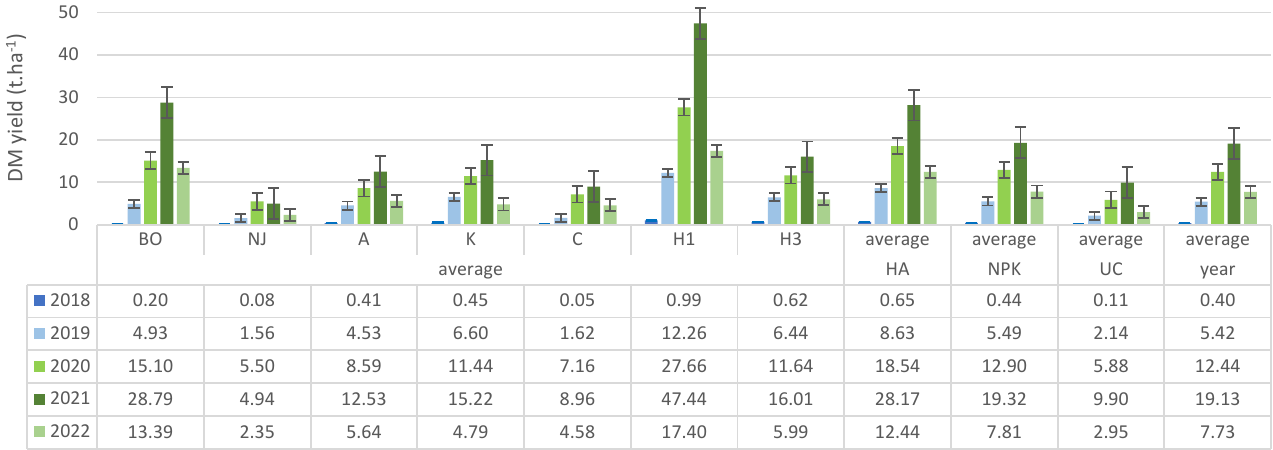
Figure 2. The dry matter yield according to cultivars and treatments, average data with standard deviation added. The mistake is the first “UC” on x-axix – correct is “C” only, while the second “UC” on the axis is fully correct.